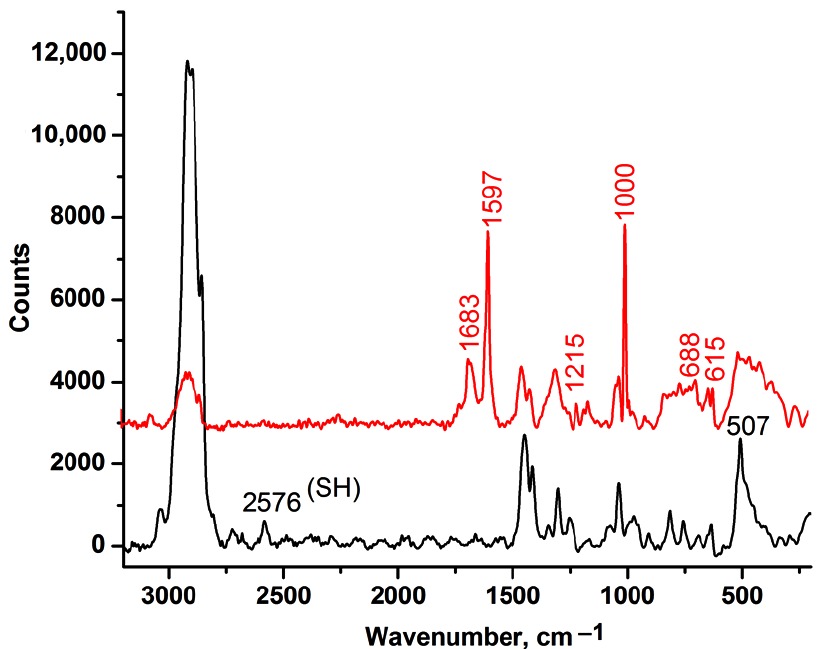
Figure 1. Raman spectra of the mesoporous silica bearing SH groups (MSil2, black line) and the one reacted with allyl-glucoside (MSil3, red line).